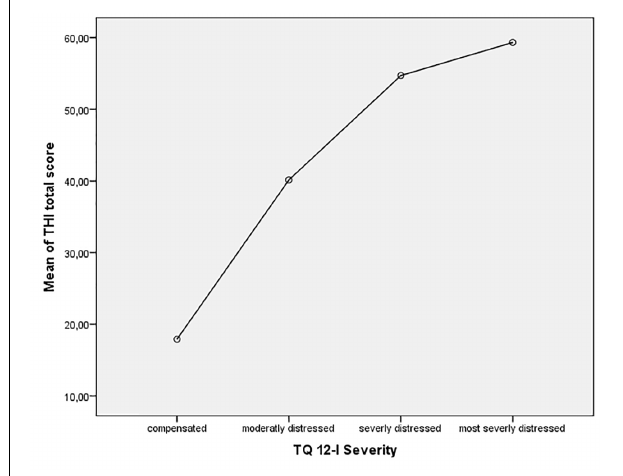
FIGURE 2 | Comparison of TQ 12-I severity groups with THI total